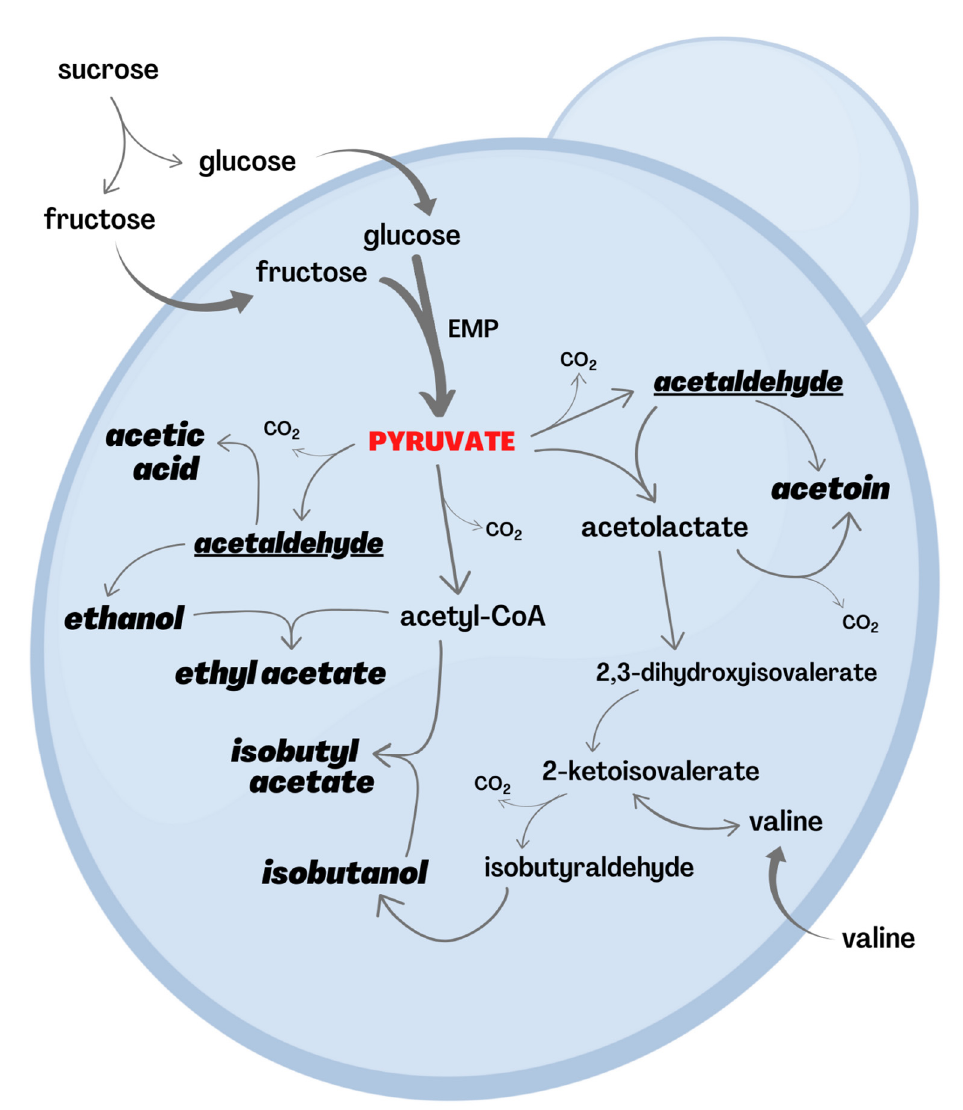
Figure 2. Pyruvate’s central role in VOC production from sugars occurring within the cells of Saccharomyces cerevisiae and other model yeasts. The hexoses glucose and fructose can be directly available in nectar or be generated from sucrose hydrolysis. Each mol of these hexoses is converted into two mols of pyruvate through the Embden–Meyerhof–Parnas (EMP) pathway, herein represented by a thick arrow. Pyruvate also works as a precursor of amino acids, such as valine, which can be found in nectar as well. VOCs are shown in bold italics. Acetaldehyde (underlined) can be either secreted as any other volatile compound or converted into different VOCs. Enzymes and coenzymes were omitted for the sake of simplification. Carbohydrate metabolism in Metschnikowia and other non- Saccharomyces yeasts prevalent in floral nectar remains greatly understudied. For further details, see the main